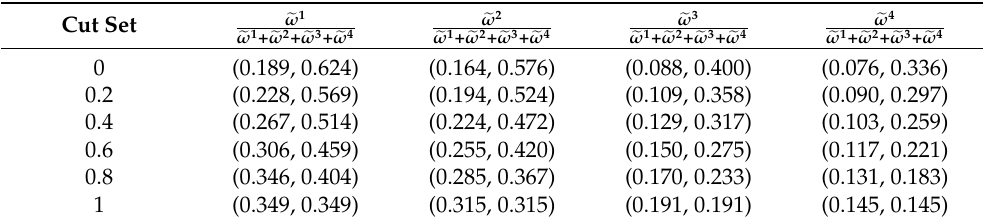
Table 7. Fuzzy weight λ cut set of evaluation factors for loading and unloading truss robot for CNC punch.